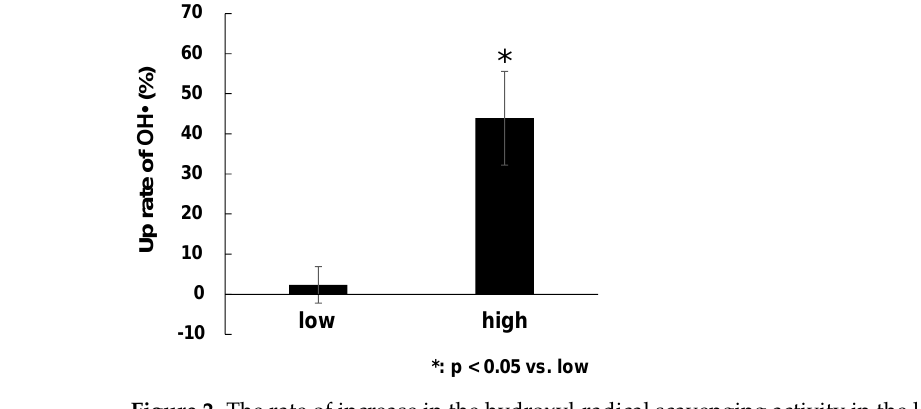
Figure 2. The rate of increase in the hydroxyl-radical scavenging activity in the low- and high-mean power groups in the Wingate exercise test. The group with high-mean power exhibited significantly